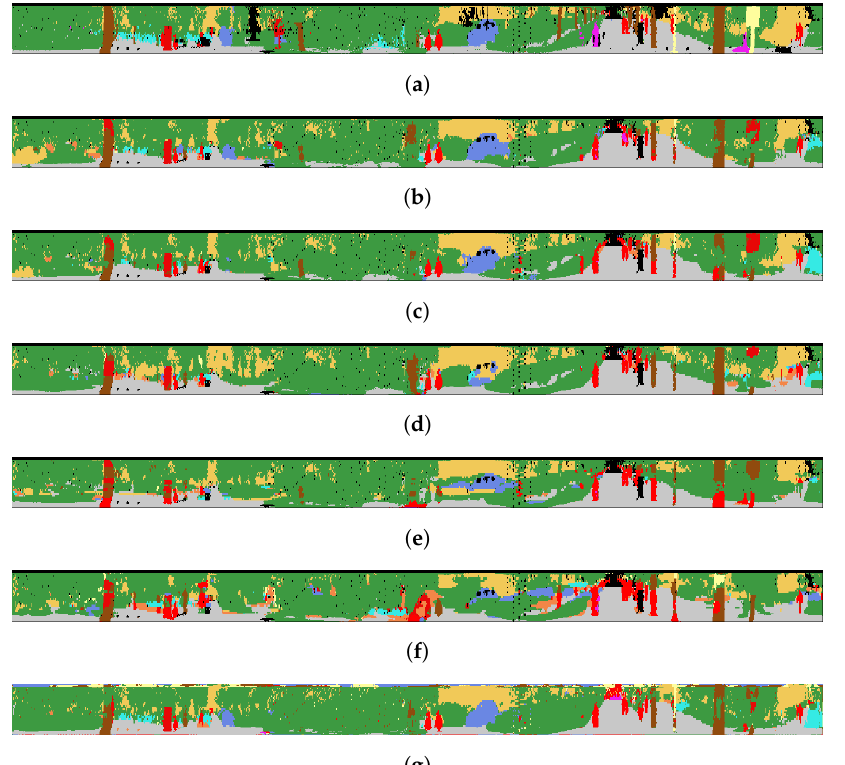
Figure 6. Qualitative results of the methods for SemanticPOSS. ( a ) Ground Truth; ( b ) SegUNet3D;